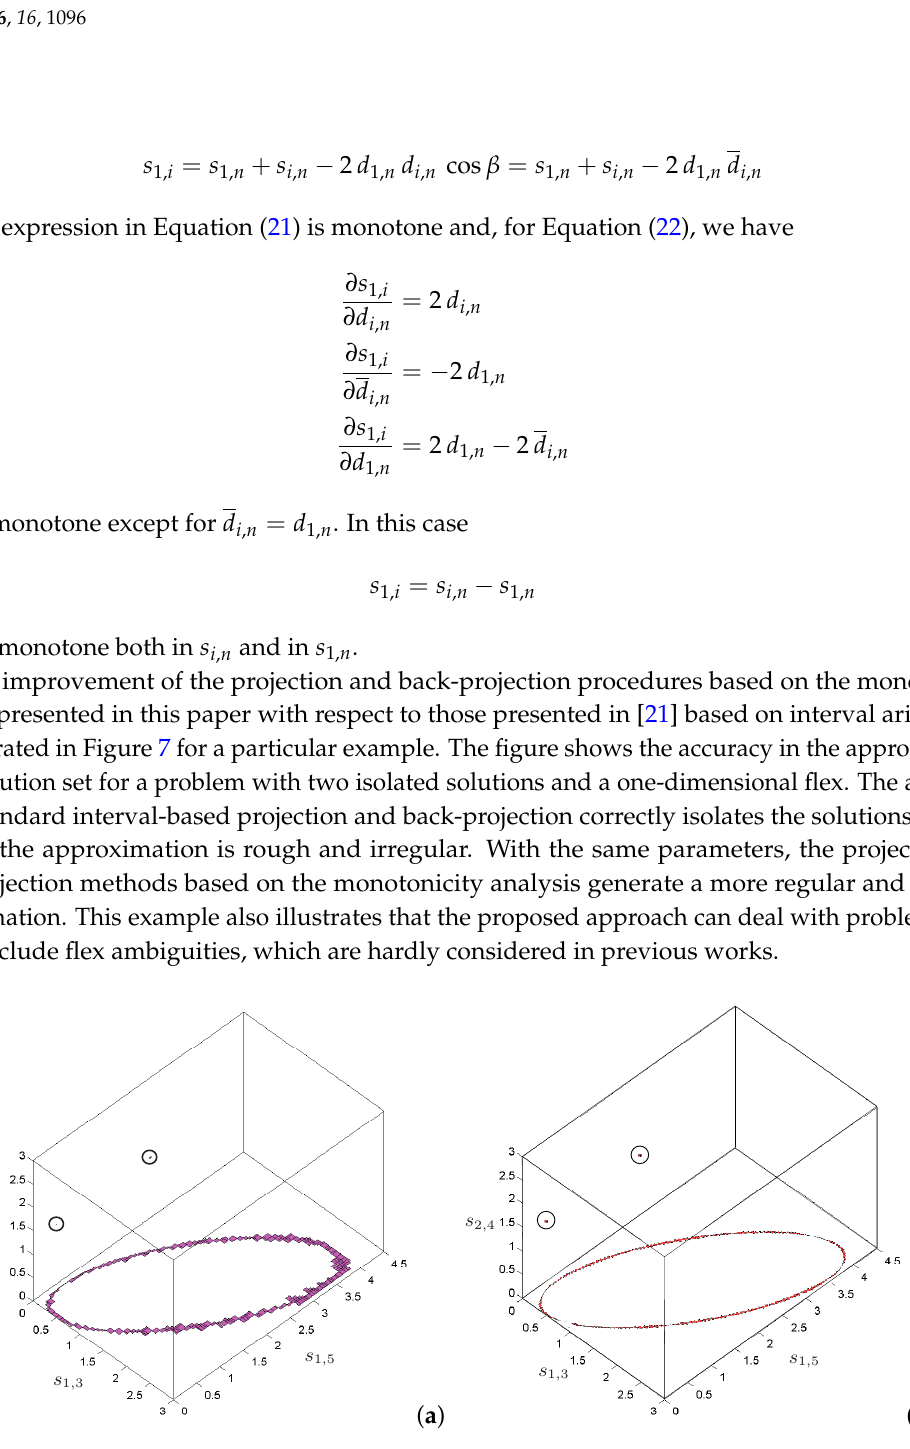
Figure 7. Approximation of the solution space for a problem with two isolated solutions and a one-dimensional flex. The isolated solutions are encircled to make them visible. ( a ) Using a projection and back-projection relying on standard interval arithmetics we obtain a rough approximation of the flex. ( b ) Using the monotonicity-based alternative introduced in this paper over-estimations are avoided and the flex is tightly